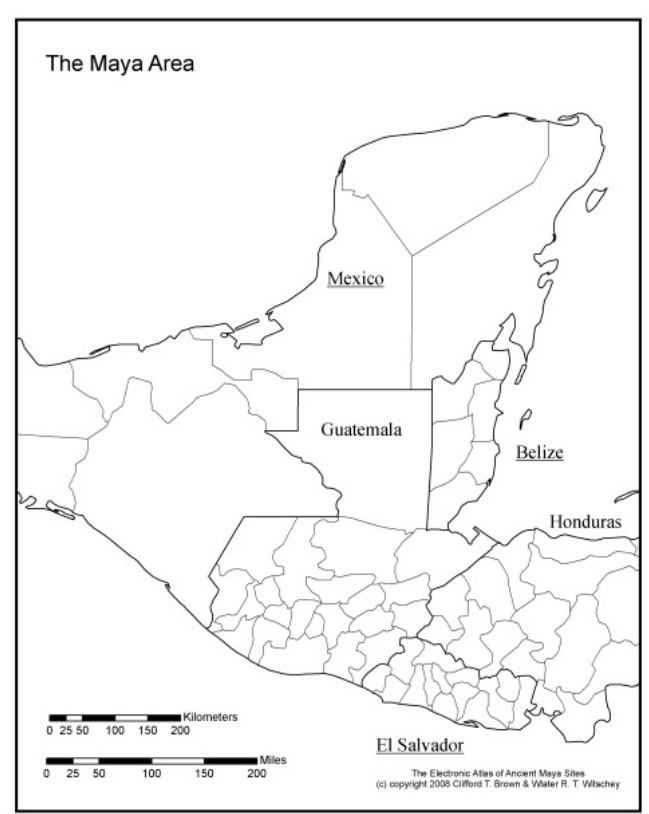
Figure 7. Map of the Maya area (modified from [51]).